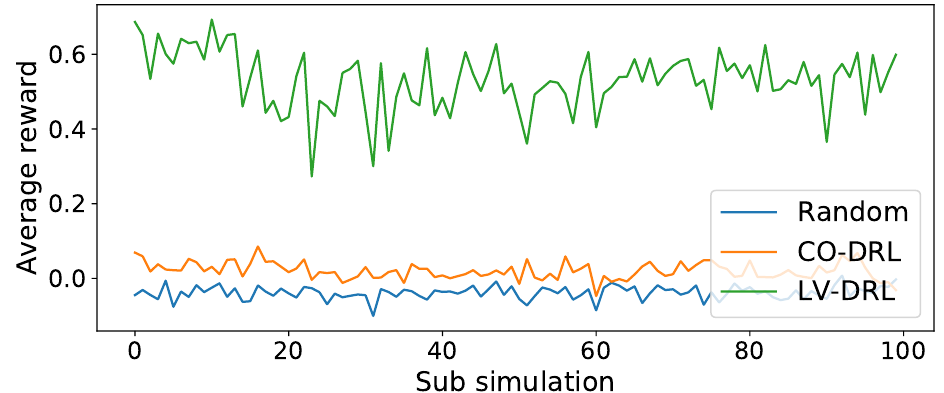
Figure 4. Average rewards of each sub simulation in validation. Orange and blue lines represents average rewards of deep reinforcement learning (DRL) and random (baseline) models.